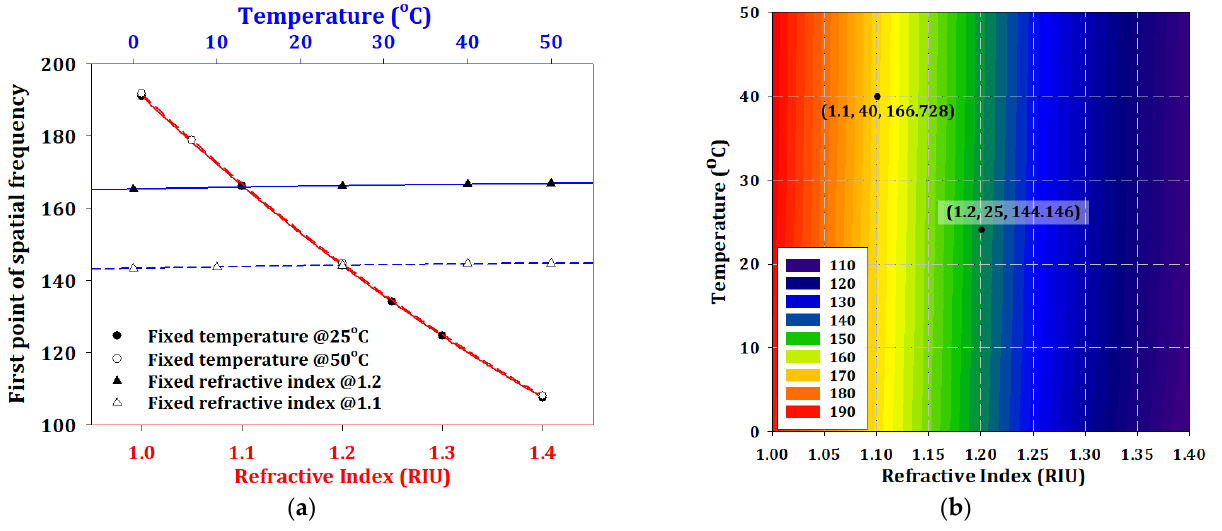
Figure 8. ( a ) The FPSF distribution with different temperatures and a refractive index of 1.3, ( b ) the distribution map for different temperatures and refractive indices.